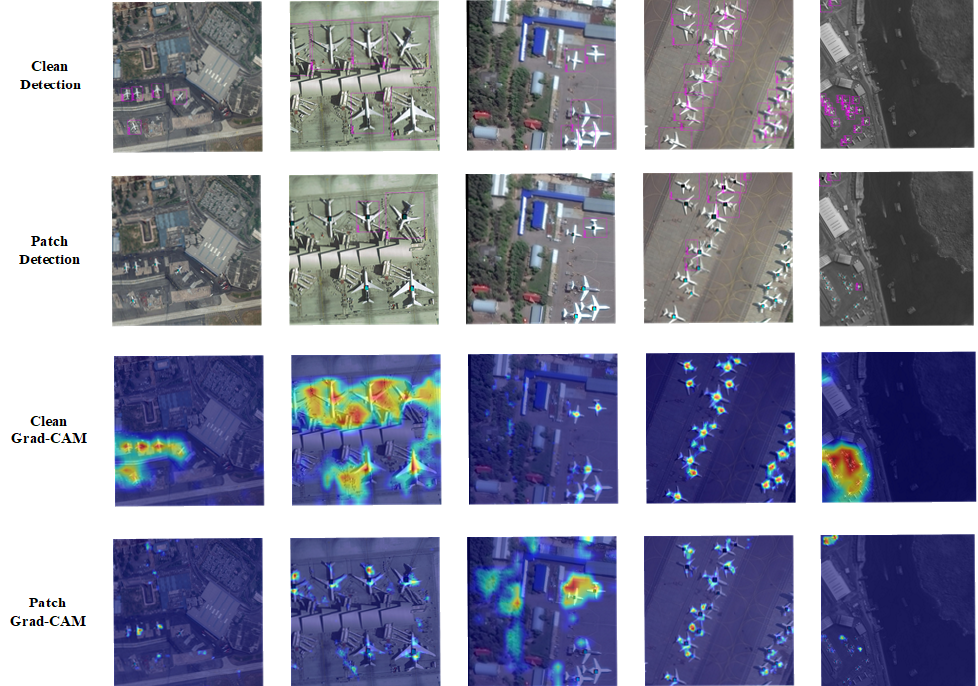
Figure 5. Grad-CAM visualization results for normal and adversarial examples. Each column in the figure represents the detection results and Grad-CAM visualization results of a normal example and its corresponding adversarial